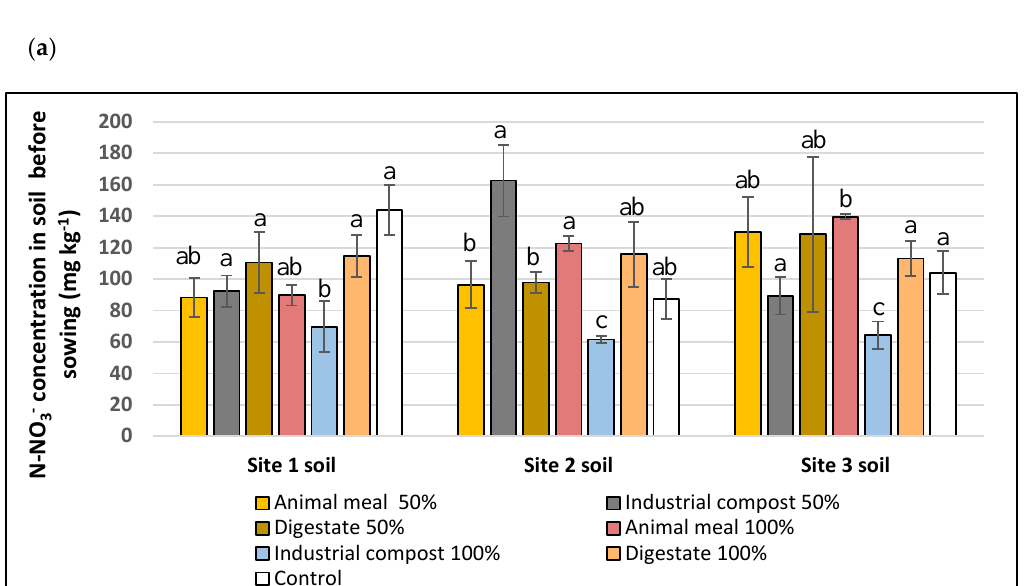
Uppercase letters indicate significant differences between soils based on Tukey’s test. Means marked with the same letter did not differ significantly ( p < 0.05).